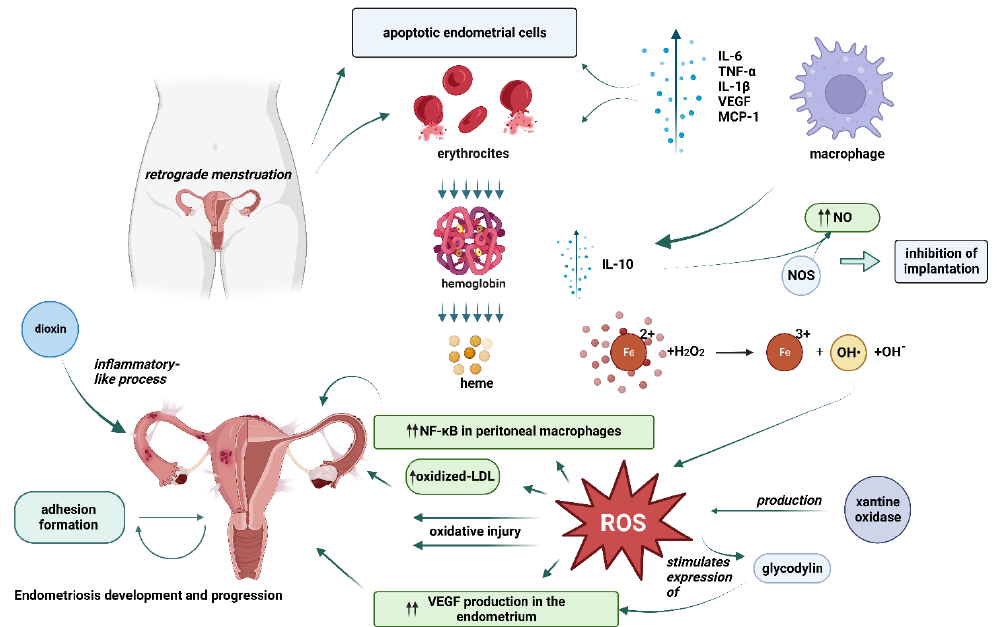
Figure 2. Potential mechanisms of oxidative stress related-endometriosis development. One of the many mechanisms is related to the activation of immune system caused by endometrial cells entering the peritoneal cavity during retrograde menstruation, which leads to excess reactive oxygen species (ROS) production by the activated macrophages, apoptotic endometrium cells, and erythrocytes. Iron, the by-product of hemolysis, then may act as a catalyst in the Fenton reaction further generating ROSs. Apart from direct oxidative injury to endometrial cells, ROSs can also increase the production of nuclear factor-kappa B (NF- κ B) and vascular endothelial growth factor (VEGF) which play a role in the immune and inflammatory response in endometriotic cells and lead to an increase in levels of cytokines, chemokines, adhesion molecules, growth, and angiogenic factors all of which are related to the development and progression of endometriosis. (This figure was created with BioRender.com). It has been suggested that when endometrial cells get to the peritoneal cavity during retrograde menstruation, the immune system is activated and excess ROS are produced by activated macrophages, apoptotic endometrium cells, and erythrocytes [2,25]. Several studies have indicated that endometriosis patients have dysregulated immune